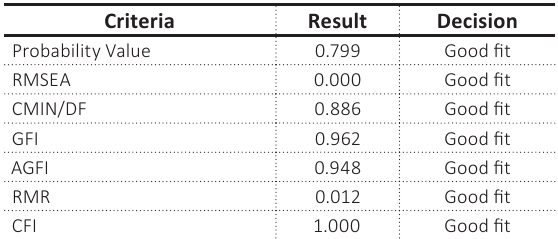
Table 3. The goodness of fit test results